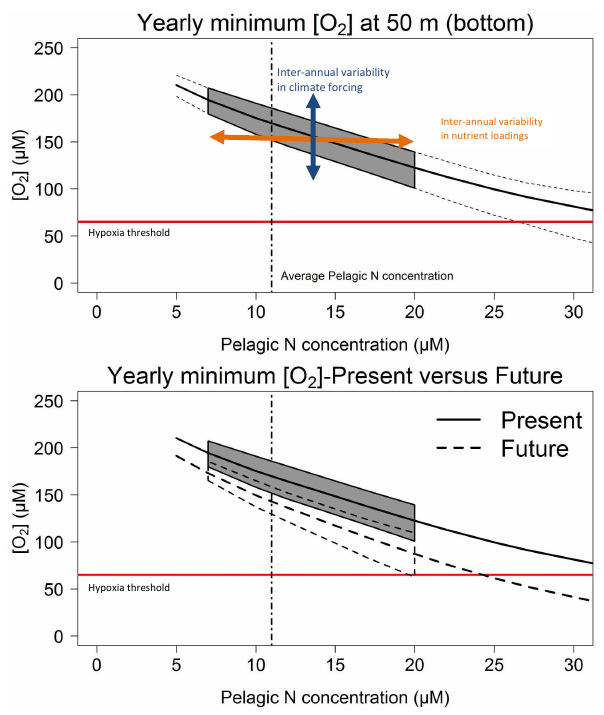
Fig. 11. Effect of increasing pelagic nitrogen concentration on the yearly minimum oxygen concentration ([O 2 ]) at 50m depth (bot- tom). The current average pelagic nitrogen concentration (11µM) is indicated with a vertical dashed line. The horizontal red line at 63µM indicates the hypoxia threshold. Top panel: using present cli- mate forcings (year 2000). The dotted lines indicate the minimum and maximum concentration of the different climate simulations of 2000; polygon indicates the likely area of oxygen concentrations. The arrows indicate the interannual variability in climate forcings and nutrient loadings. Bottom panel: comparison between present (year 2000) and future climate forcings (year 2100). The polygon is grey for the present climate forcings and transparent (dotted line) for the future climate forcings.